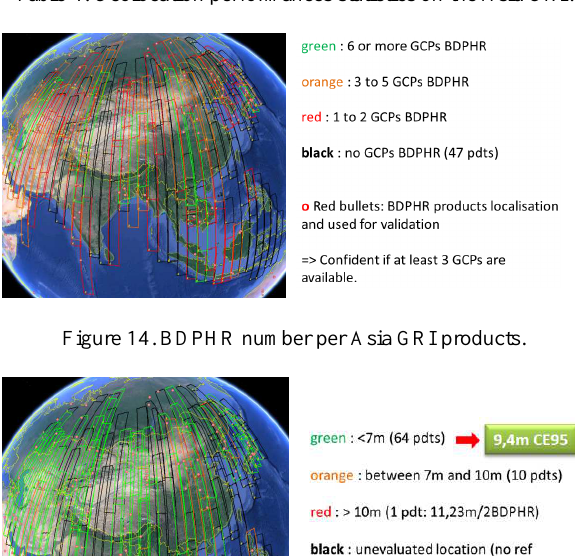
Table 4. Geolocation performances statistics on the Asia GRI.